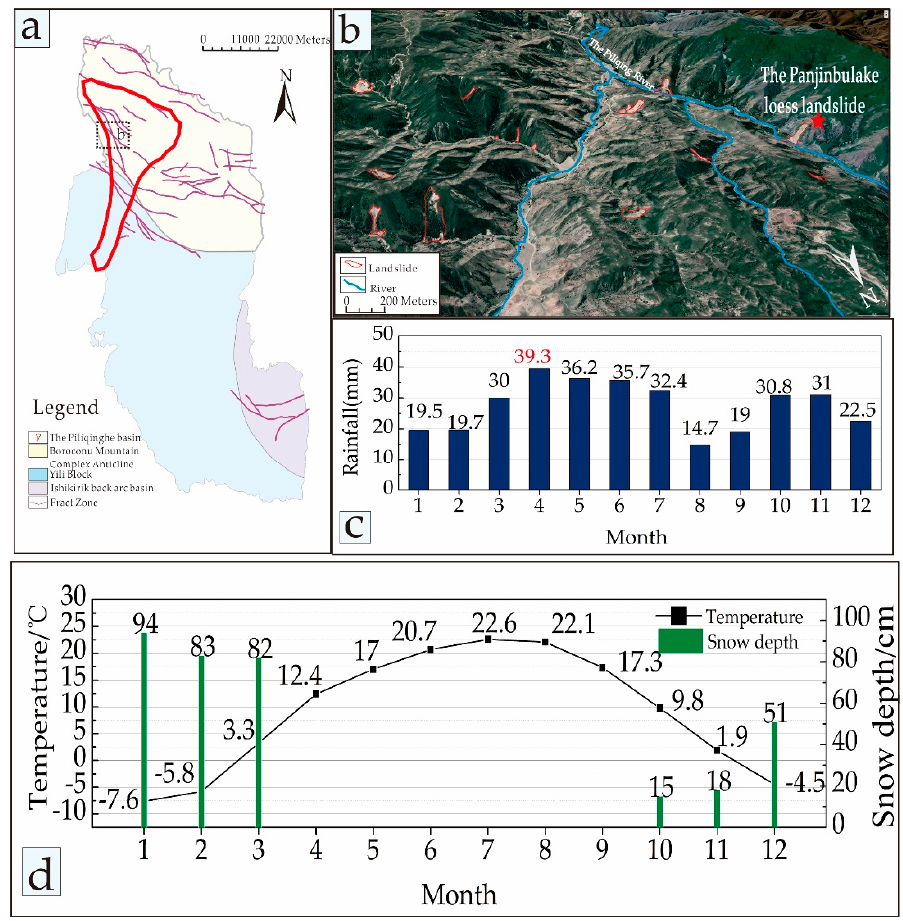
Figure 2. ( a ) The geological structure map in Yining Country. ( b ) The loess landslide distribution in the Piliqinghe Basin. ( c ) The monthly average precipitation of Yining County over time (2011–2016). ( d ) The monthly average temperature–snow depth map of Yining County over time (2011–2016).